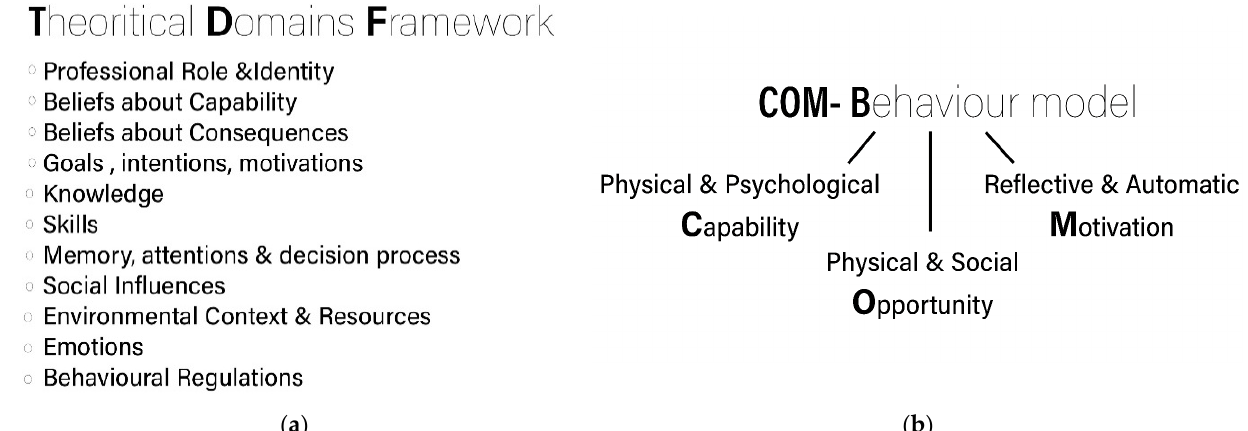
Figure 1. Behaviour change frameworks taking built and social environment into consideration: ( a ) Theoretical Domains Framework (adapted by [54] ); ( b ) COM-B model (adapted by [55] ).